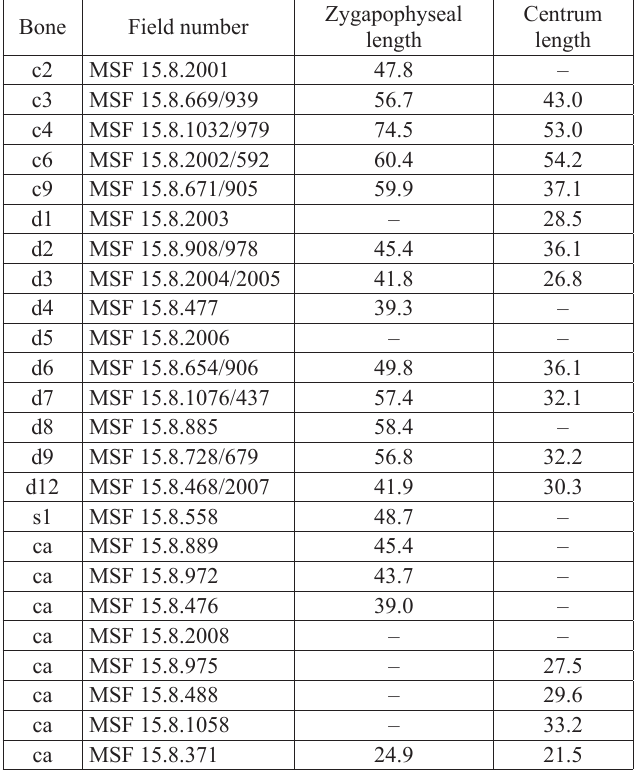
Table 1. Selected measurements (in mm) of axial skeleton of juvenile Plateosaurus cf. trossingensis (MSF 15.8B.). Zygapophyseal length is the maximum length between pre- and postzygapophyses projected into the sagittal plane. Centrum length is measured “rim to rim” in a straight line in the sagittal plane on the ventral side of the centrum.